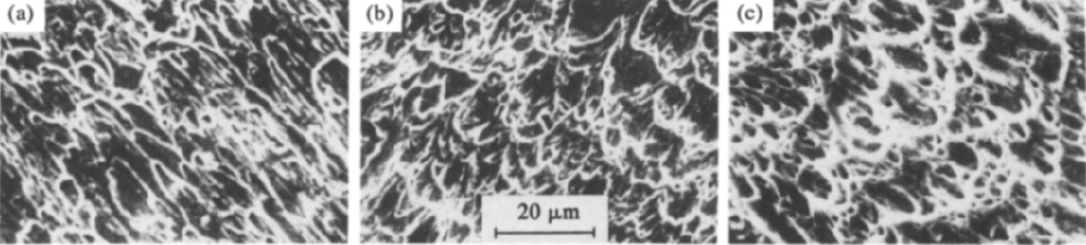
Figure 16. Fractographs of different steels: ( a ) quenched steel, ( b ) quenched and tempered steel, and ( c ) normalized steels [102] .